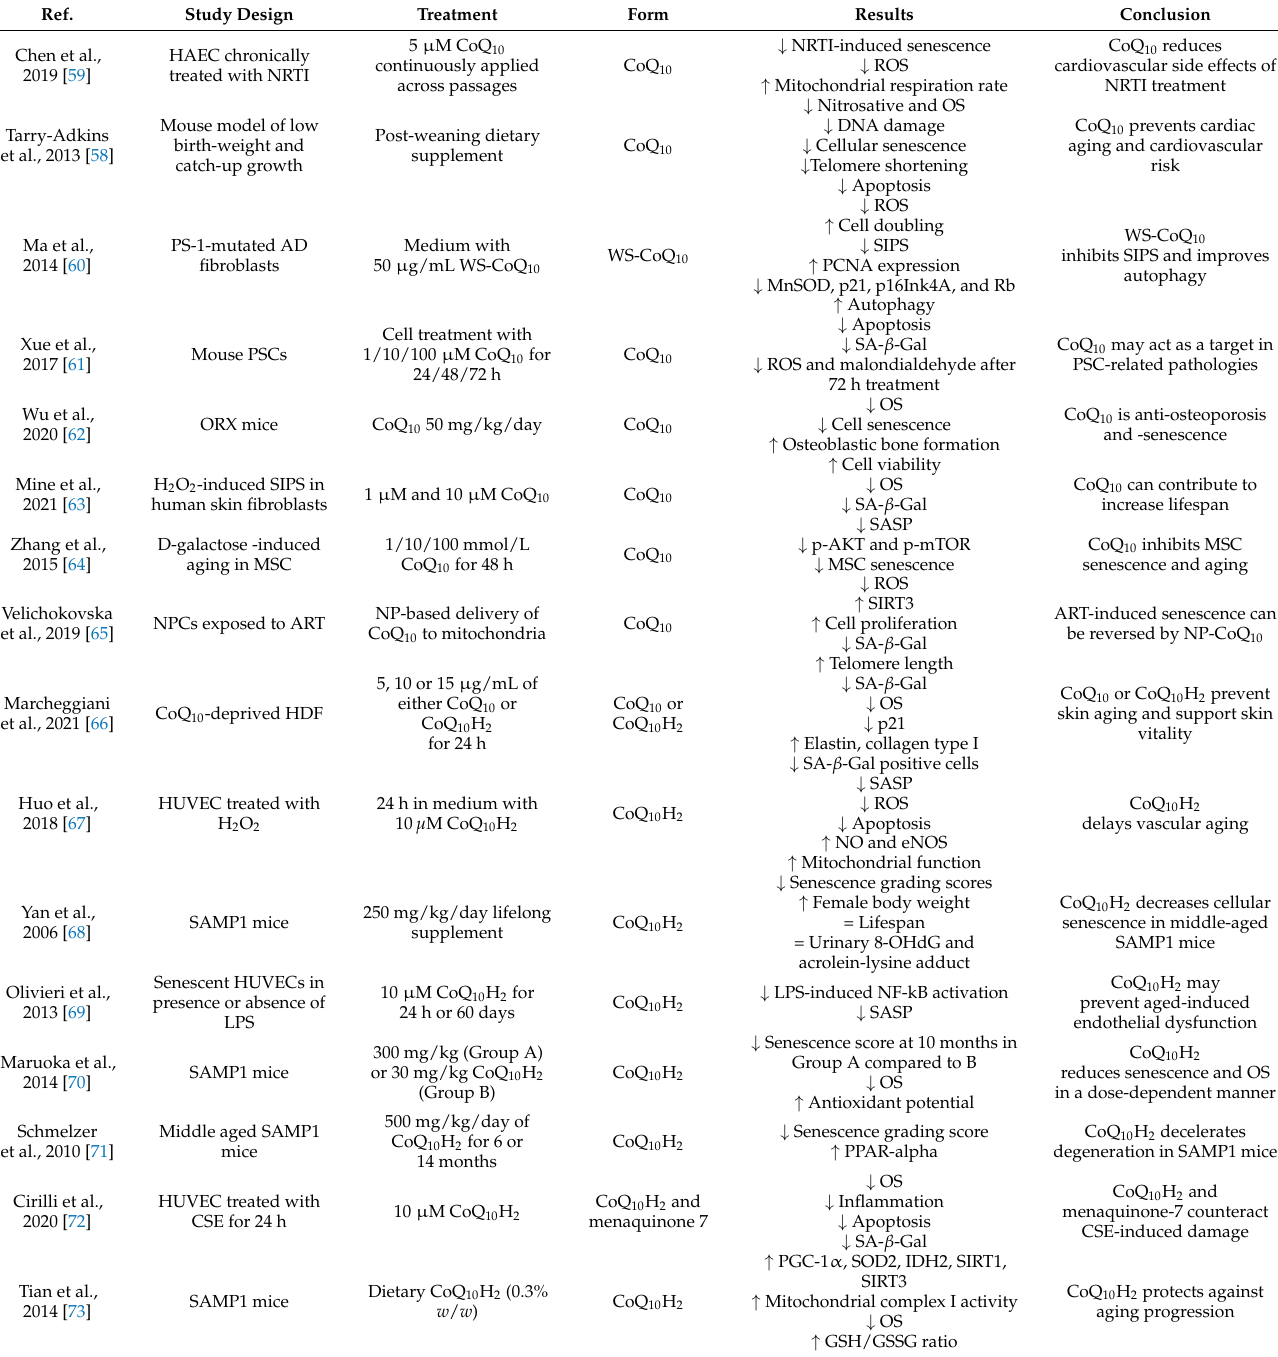
Table 1. CoenzymeQ 10 and ubiquinol in the prevention of OS-induced